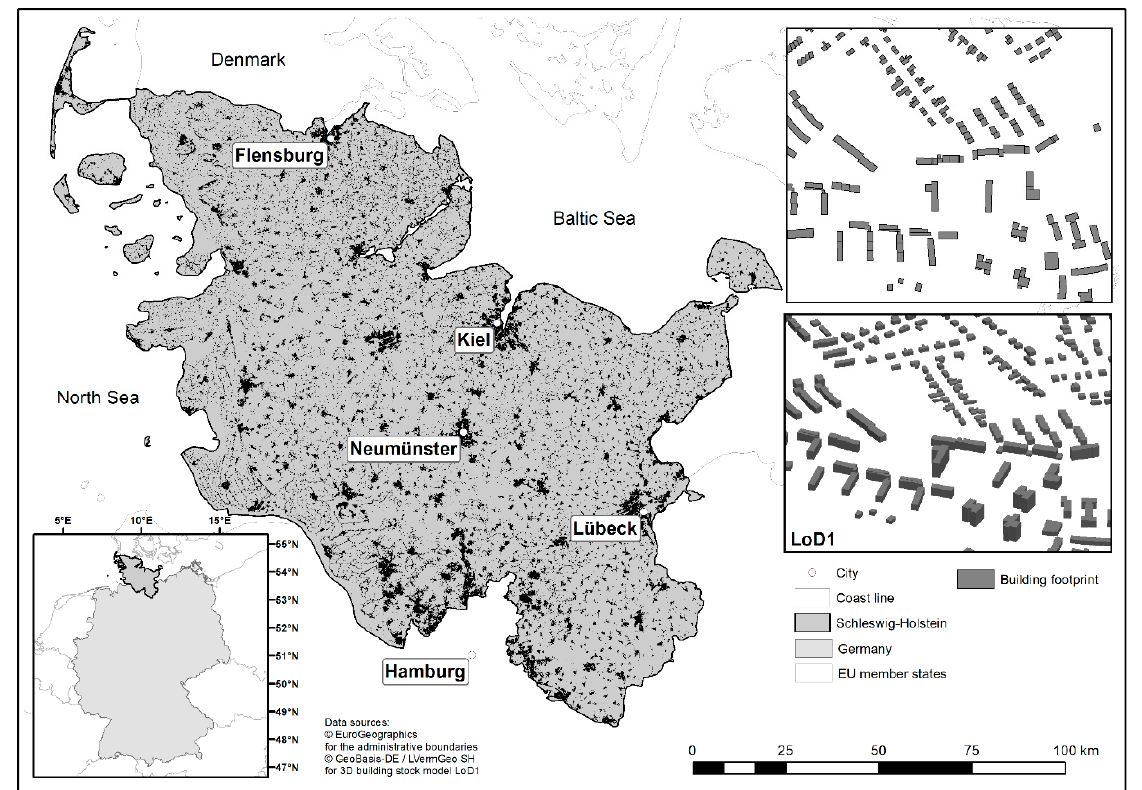
Figure 1. 3D building stock model for the German federal state of Schleswig ‐ Holstein and major